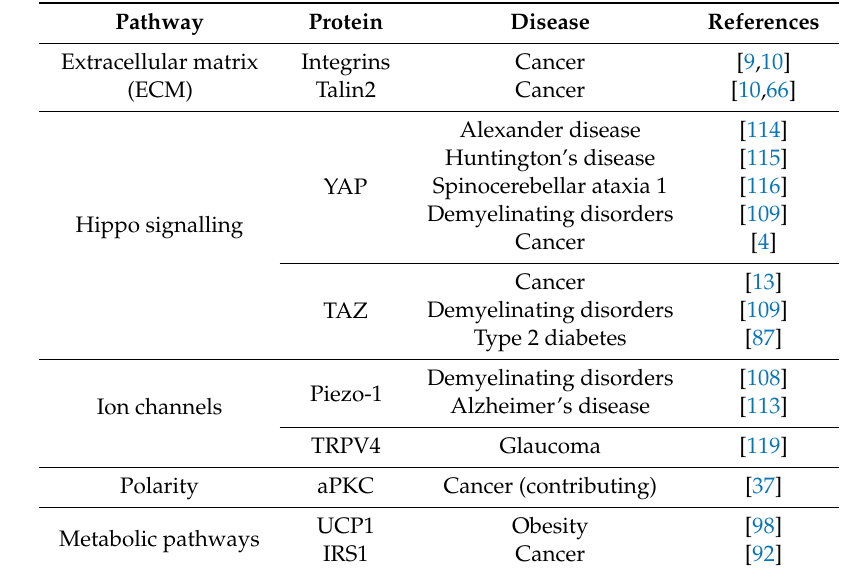
Table 1. Proteins discussed in this review involved in mechanotransduction and diseases associated with their